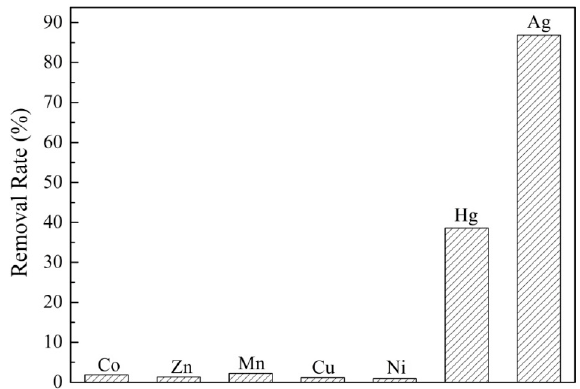
Figure 7. Selective adsorption of TSC-CC resin for Ag + .